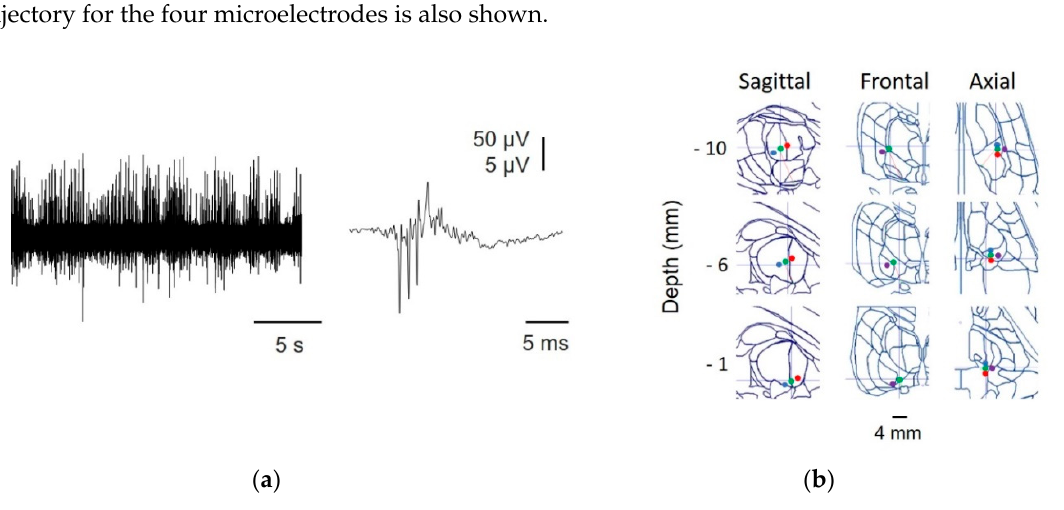
Figure A1. Identification of thalamic nuclei. ( a ) Raw MER (left) and high frequency oscillations (HFO) obtained by SSEP (right); ( b ) reconstruction of the trajectory from one patient, showing microelectrode (anterior = blue, central = green, posterior = red, and lateral = purple) positions at different depths superimposed onto an SW map. The numbers on the left indicate the true distance to the target.